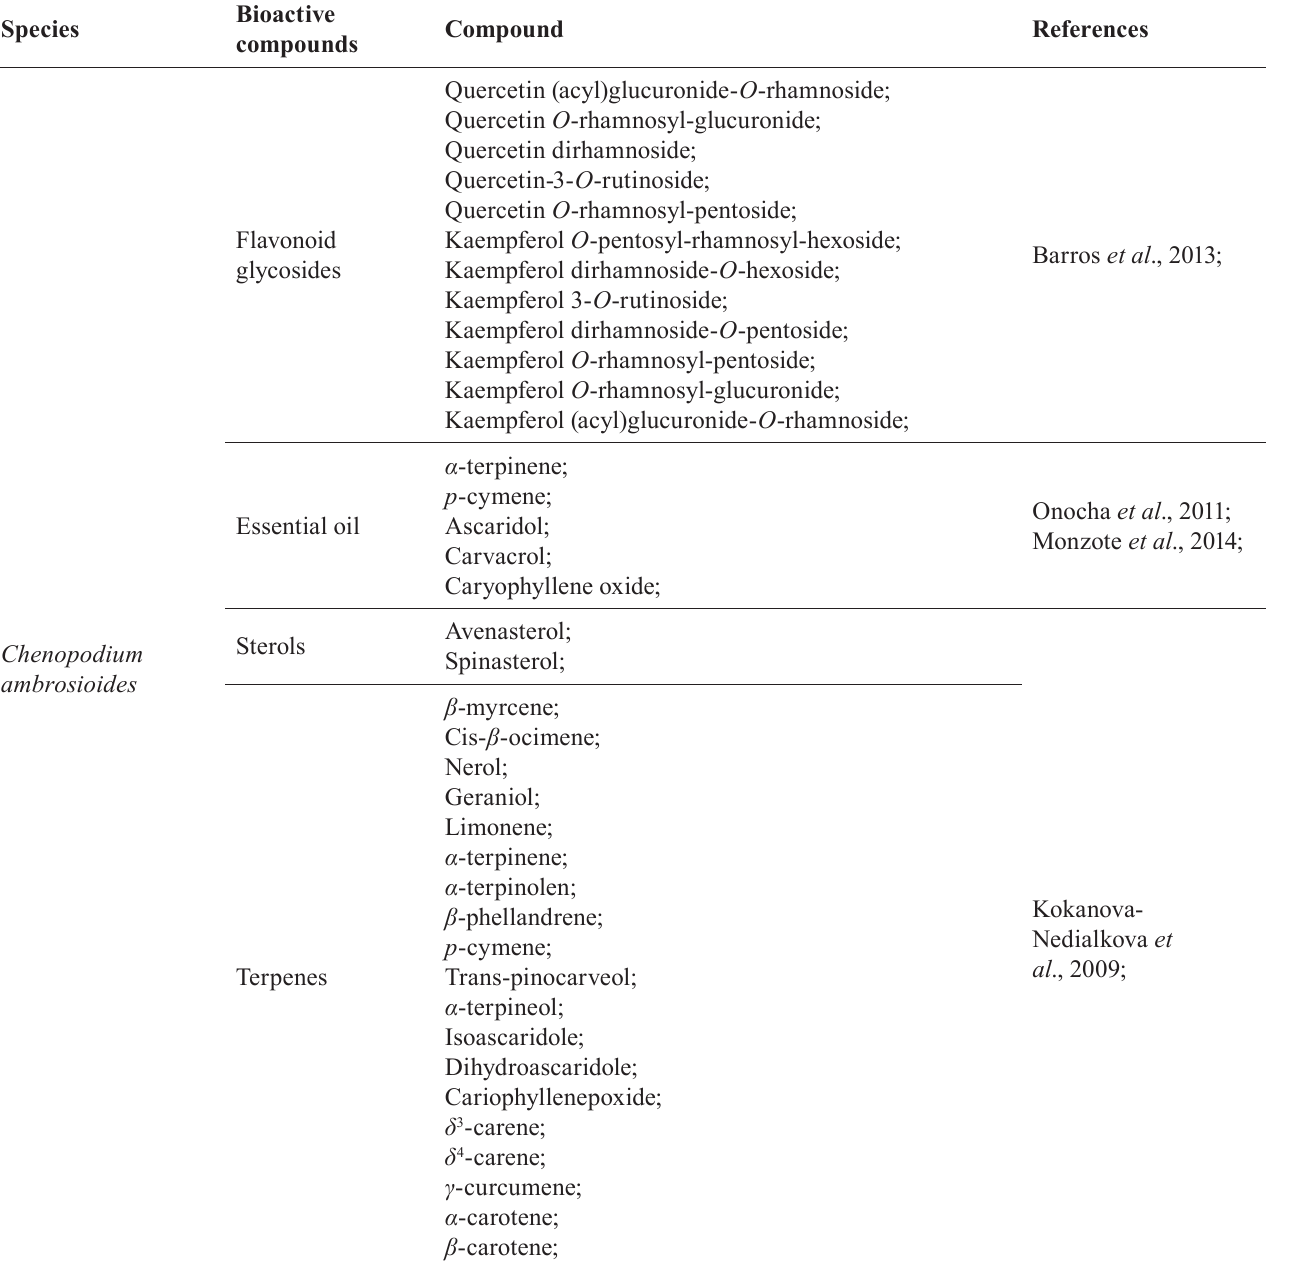
TABLE I - S econdary metabolites of presented halophytic Amaranthaceae species